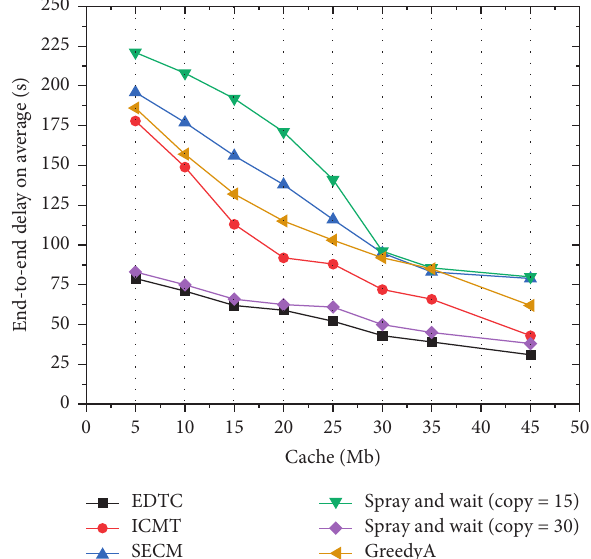
Figure 19: Relationship between end-to-end delay on average and